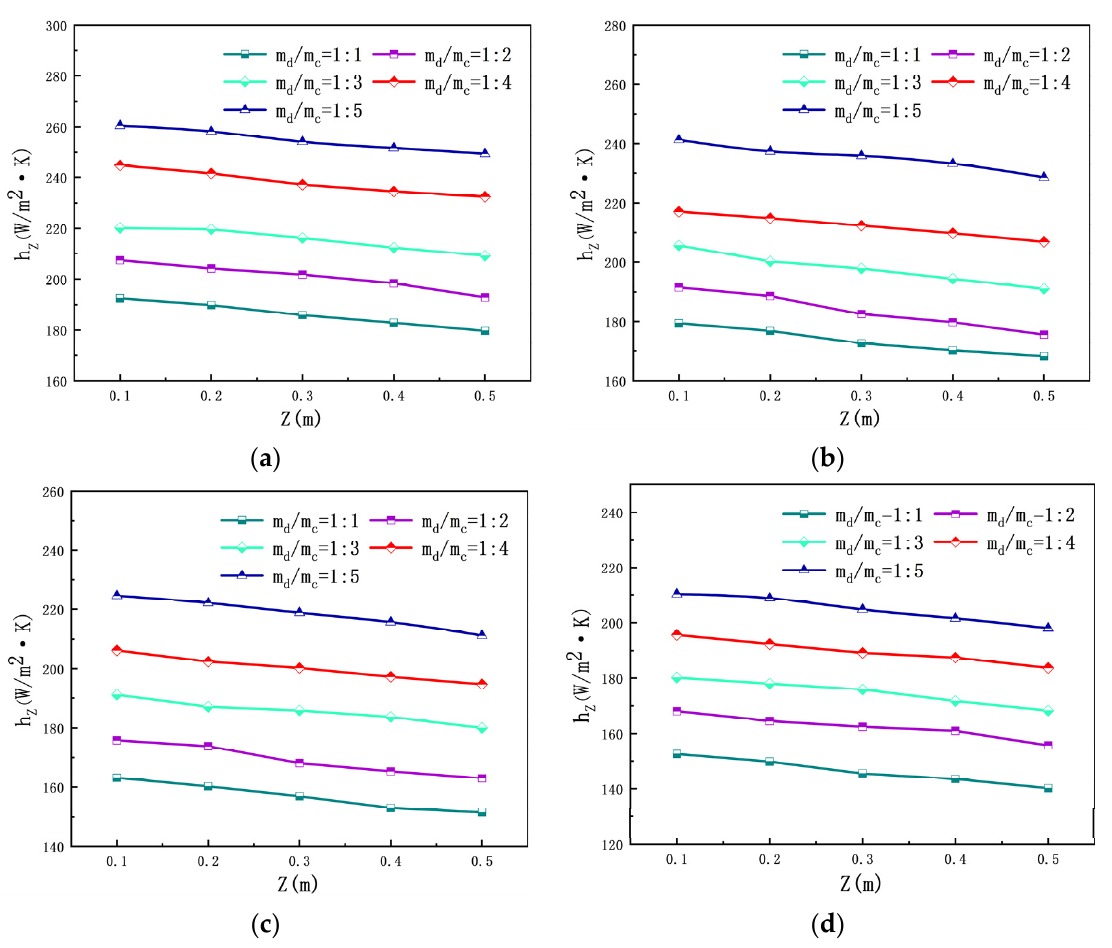
Figure 7. The relationship between the local convective heat transfer coefficient and height (Z) at different temperatures. ( a ): T c = 50 °C. ( b ): T c = 60 °C. ( c ): T c = 70 °C. ( d ): T c = 80 °C.